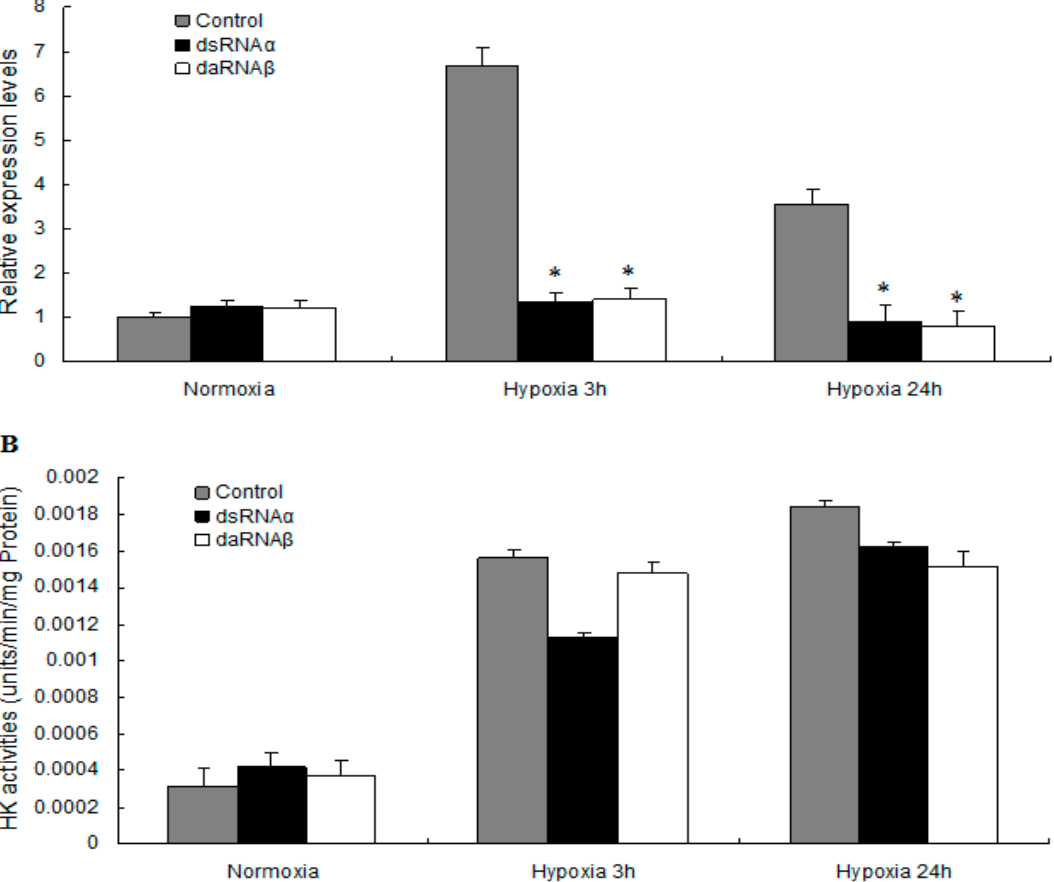
Figure 7. Hexokinase mRNA expression ( A ) and enzyme activity ( B ) in muscles during hypoxia. Prawns were exposed to hypoxia (2.0 mg/L dissolved oxygen (DO)) for 3 and 24 h and injected with saline solution (control) or HIF-1-dsRNA. Double-stranded (ds)RNA α and dsRNA β labels indicate animals injected with the corresponding dsRNA for HIF-1 α and HIF-1 β gene silencing, respectively. One-way ANOVA was used to compare the experimental treatments. (*) indicates significant differences ( p < 0.05) between the control and dsRNA α groups, between the control and dsRNA β , respectively. Vertical bars represent mean ±SEM values for triplicate samples.